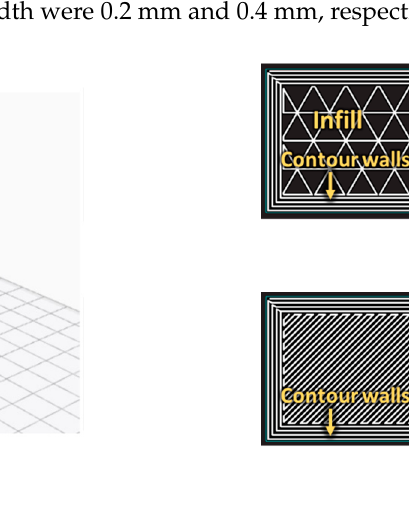
Figure 1. ( a ) 3PB specimen on a printing bed, ( b ) Central layers (with a triangular infill) and ( c ) Top/bottom layers.